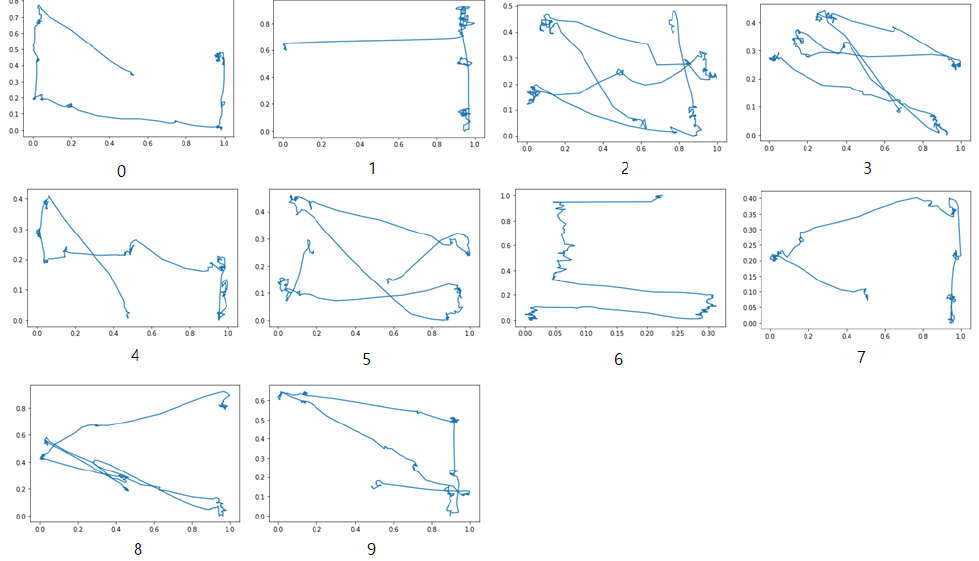
Figure 2. Eye-written characters